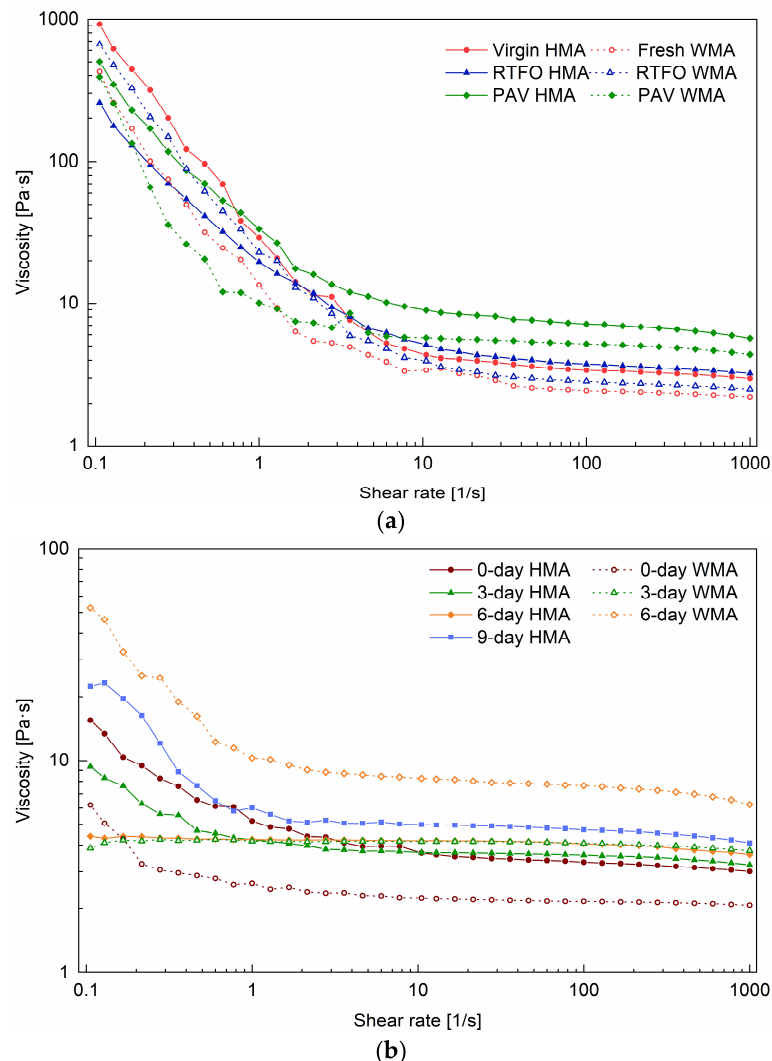
Figure 5. Shear rate dependency of viscosity of the binders at 120 °C before and after ageing: ( a ) for groups 1, 2, and ( b ) for groups 3 and 4.